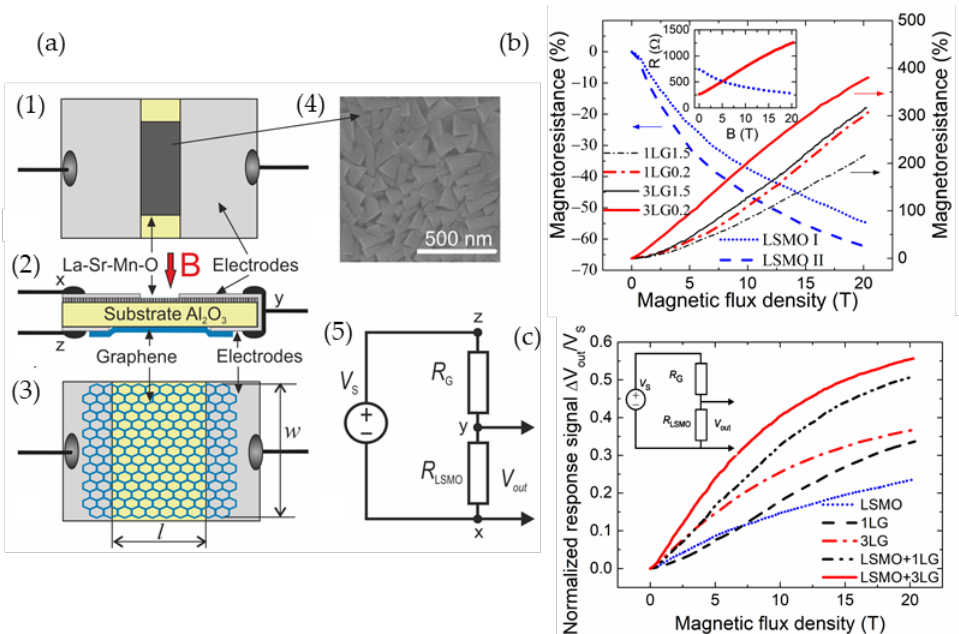
Figure 19. ( a ) (1)–(3) Schematic representation of manganite/graphene sensor. Magnetic field ( B ) applied perpendicular to the layers. (4) SEM image of LSMO film. (5) Electrical circuit of the sensor. R G and R LSMO are resistances of graphene and manganite, respectively. vs. = 1.25 V. ( b ) MR vs. B of manganite films deposited by pulsed injection MOCVD using one (LSMO I) or two (LSMO II) sources of precursors (left scale), and single- three-layer graphene (1LG or 3LG, respectively), when distance between electrodes was 1.5 mm (LG1.5) and 200 µm (LG0.2) keeping the same width/length ratio (w/l) = 3 measured at T = 293 K. The inset presents resistance vs. B change of LSMO II and 3LG. ( c ) Normalized voltage response vs. B for manganite/graphene sensor composed of LSMO II and 1LG or 3LG with dimensions 200 × 600 µm 2 . The voltage response from individual manganite (LSMO) and graphene (1LG and 3LG) elements are also presented. Reprinted from [140]. Copyright © 2021, AIP Publishing.